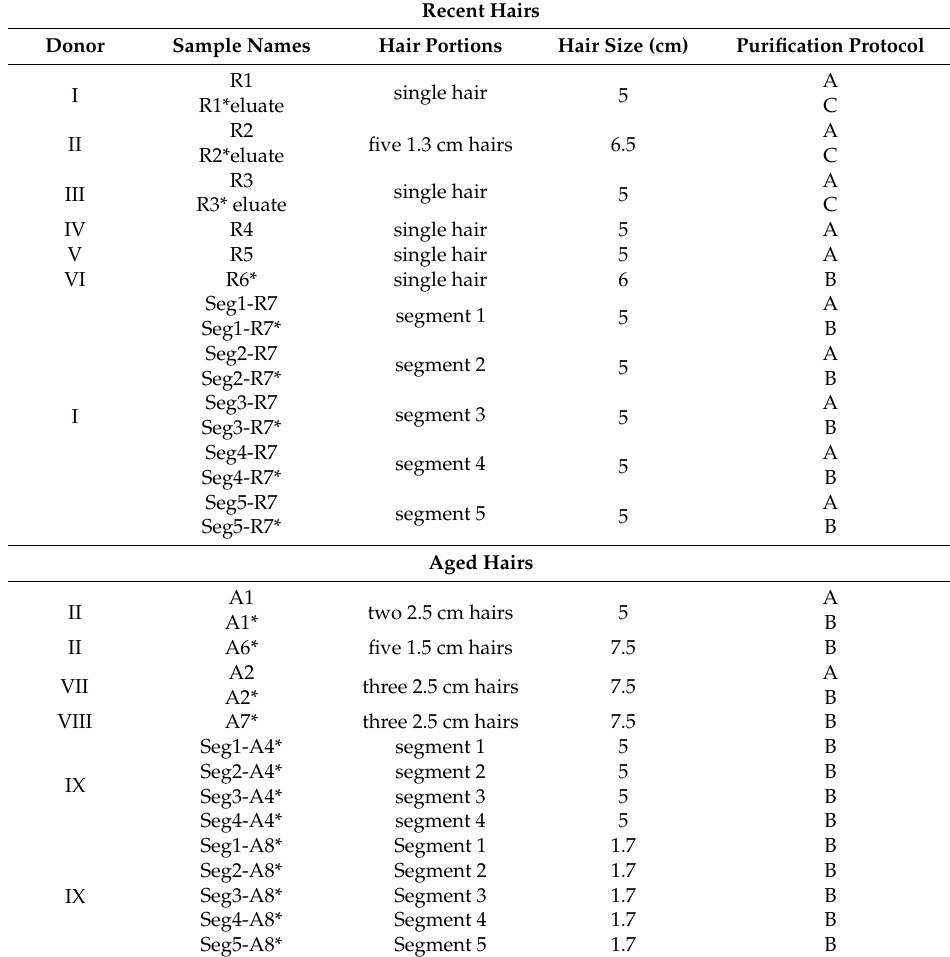
Table 2. Description of each hair sample. The asterisk denotes extracts that were obtained with purification protocol